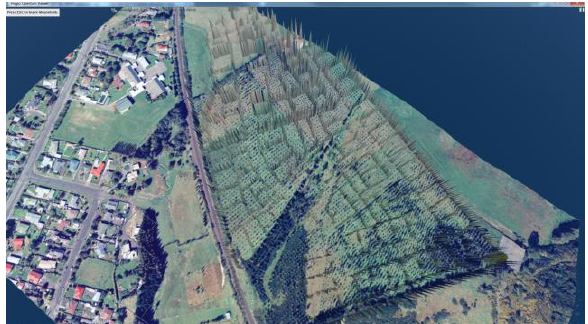
Figure 5. Part of the proposed subdivision plot in OpenSim, viewed through the Hippo Viewer. The spikes set out the parcel boundaries within the plot to guide virtual development.